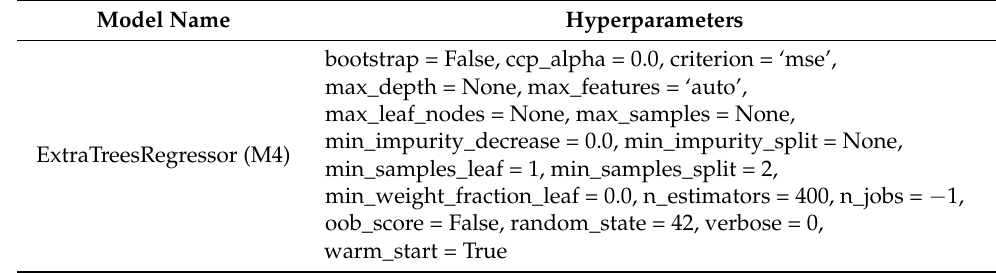
Table 4. Hyper-parameters used for building the best performing non-linear model